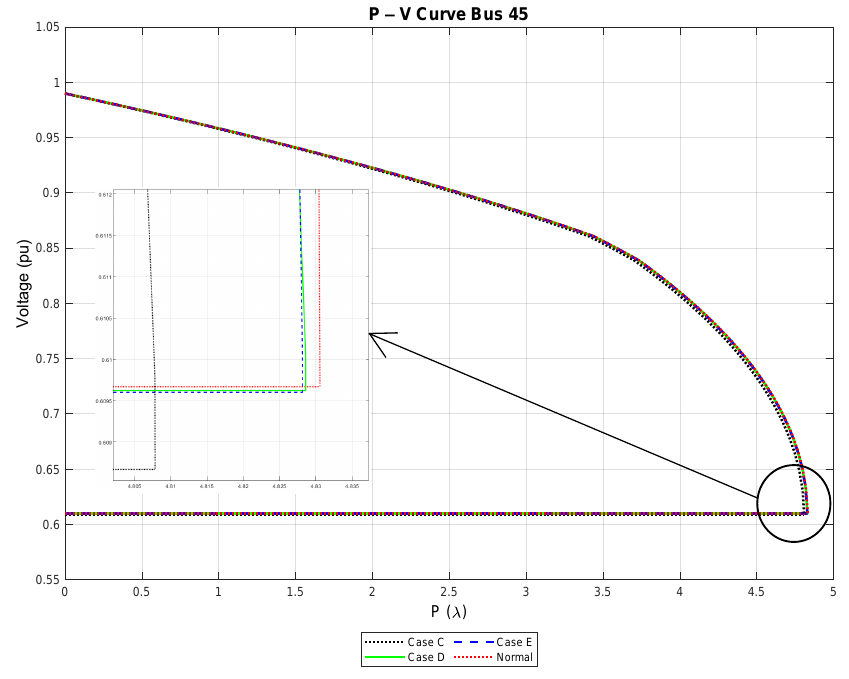
Figure 9. Voltage stability curve,